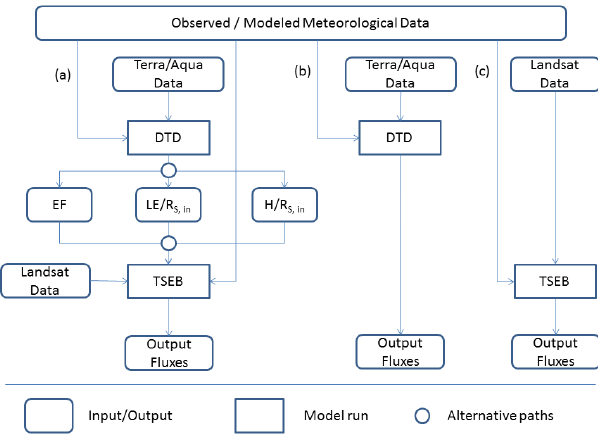
Figure 3. An overview of the different model runs being evaluated in this study. Set-up (a) shows the models and inputs/outputs used during disaggregation of 930m DTD fluxes to TSEB derived fluxes with a nominal resolution of 30m. The three constant ratios (EF, H/R s , in and LE /R s , in ) form three separate, alternative model runs. Set-up (b) shows the models and inputs/outputs used for producing 930m DTD fluxes, while set-up (c) shows the same when producing TSEB fluxes at nominal resolution of 30m directly with Landsat data and without